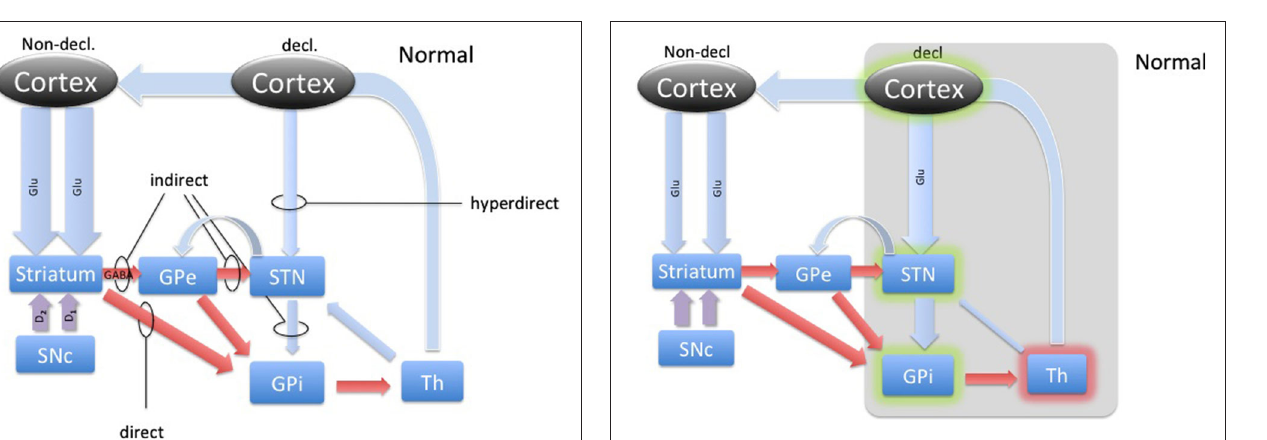
FIGURE 1 | The basal ganglia circuitry. The scheme represents the main pathways of the BG in the healthy brain with respect to declarative and implicit memory functions. Blue arrows represent glutamatergic, red arrows GABAergic and magenta arrows represent dopaminergic connections. Direct, indirect and hyperdirect pathways are indicated.